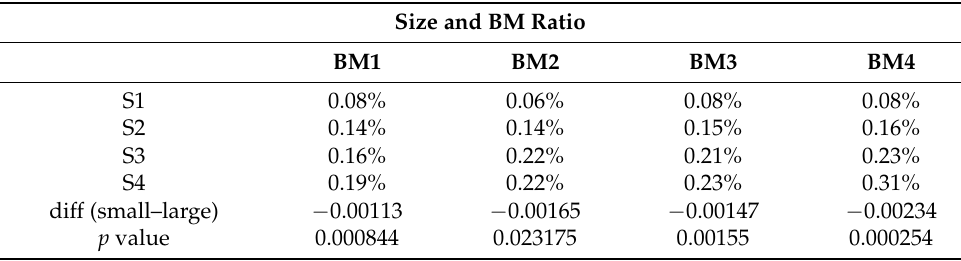
Table 3. Portfolio returns based on size and book-to-market ratio. The table represents the average returns of 24 portfolios formed oversize and book-to-market equity. A total of 527 listed firms is analyzed, from which we dropped firms with negative book-to-market equity from the sample. Firms with missing values and no data were dropped. S1 to S5 represents small to large portfolio stocks, B1 to B5 represents small book-to-market to large book-to-market ratio. Size and BM